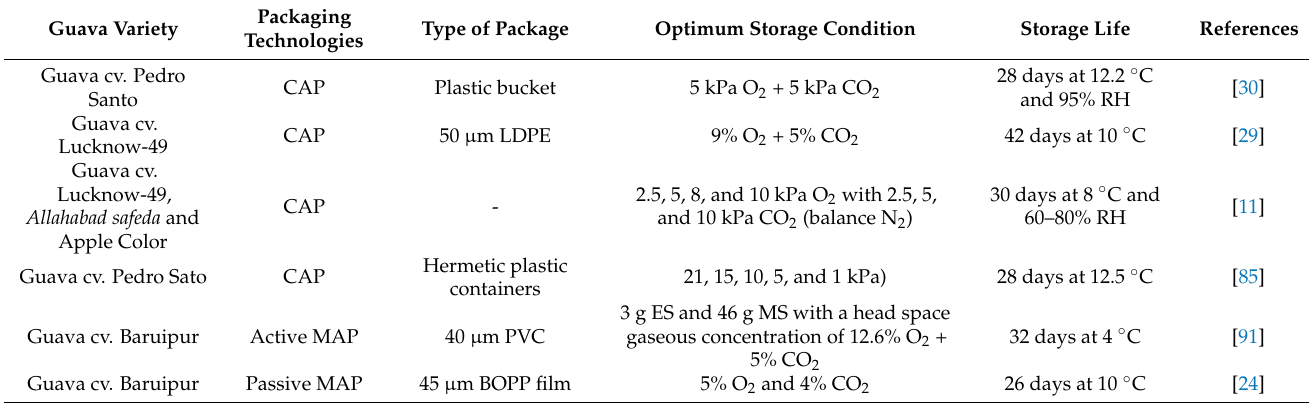
Table 1. Effect of MAP/CAP packaging on the shelf life of guava